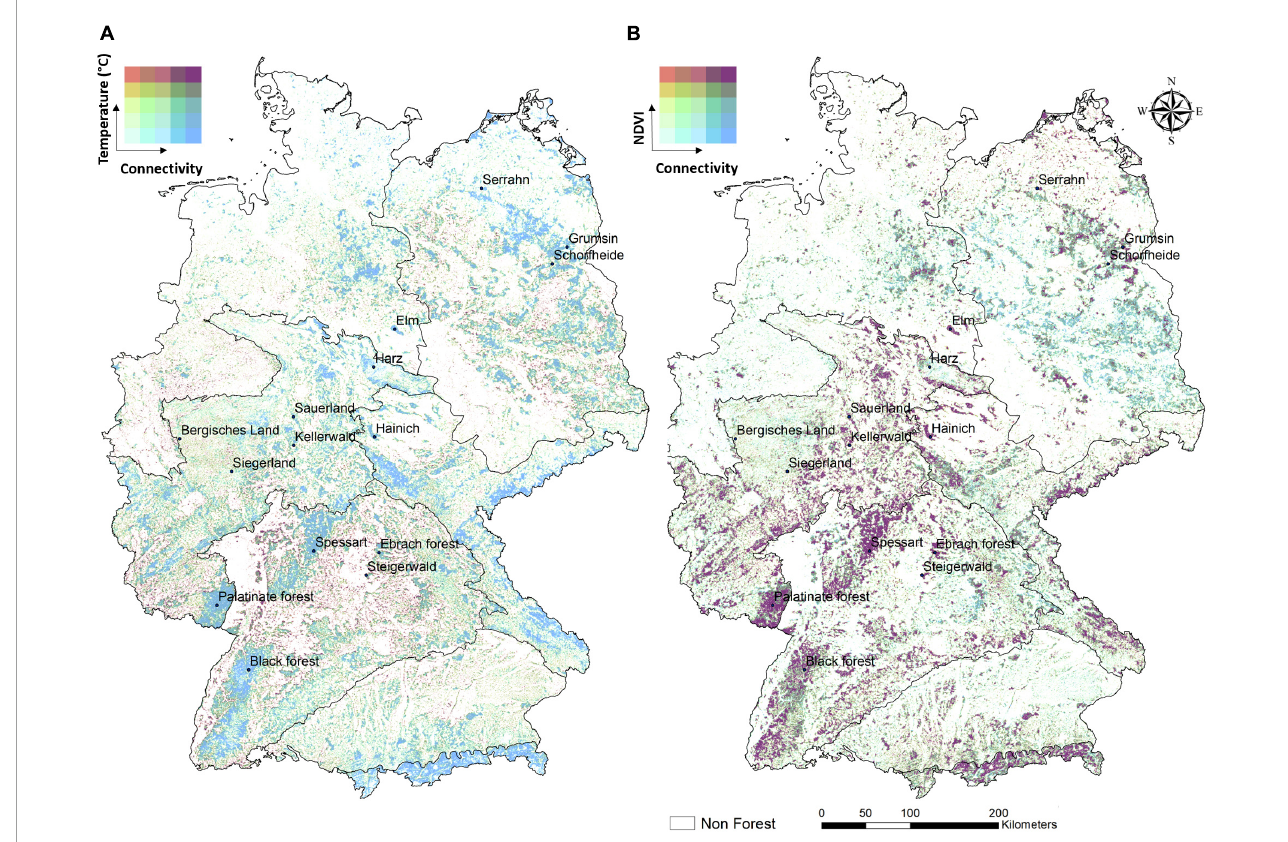
FIGURE4 Bivariate maps of tree-covered areas in Germany in 2022 and the relation between the degree of fragmentation with temperatures and vegetation vitality. (A) Thiessen connectivity and land surface temperature of hot days in 2022. (B) Thiessen connectivity and the maximum NDVI per growing season in